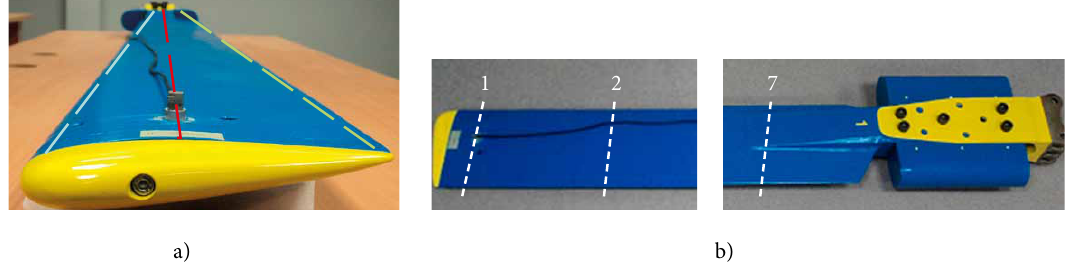
Fig. 2. Natural blade model: а) tip view; b) plan